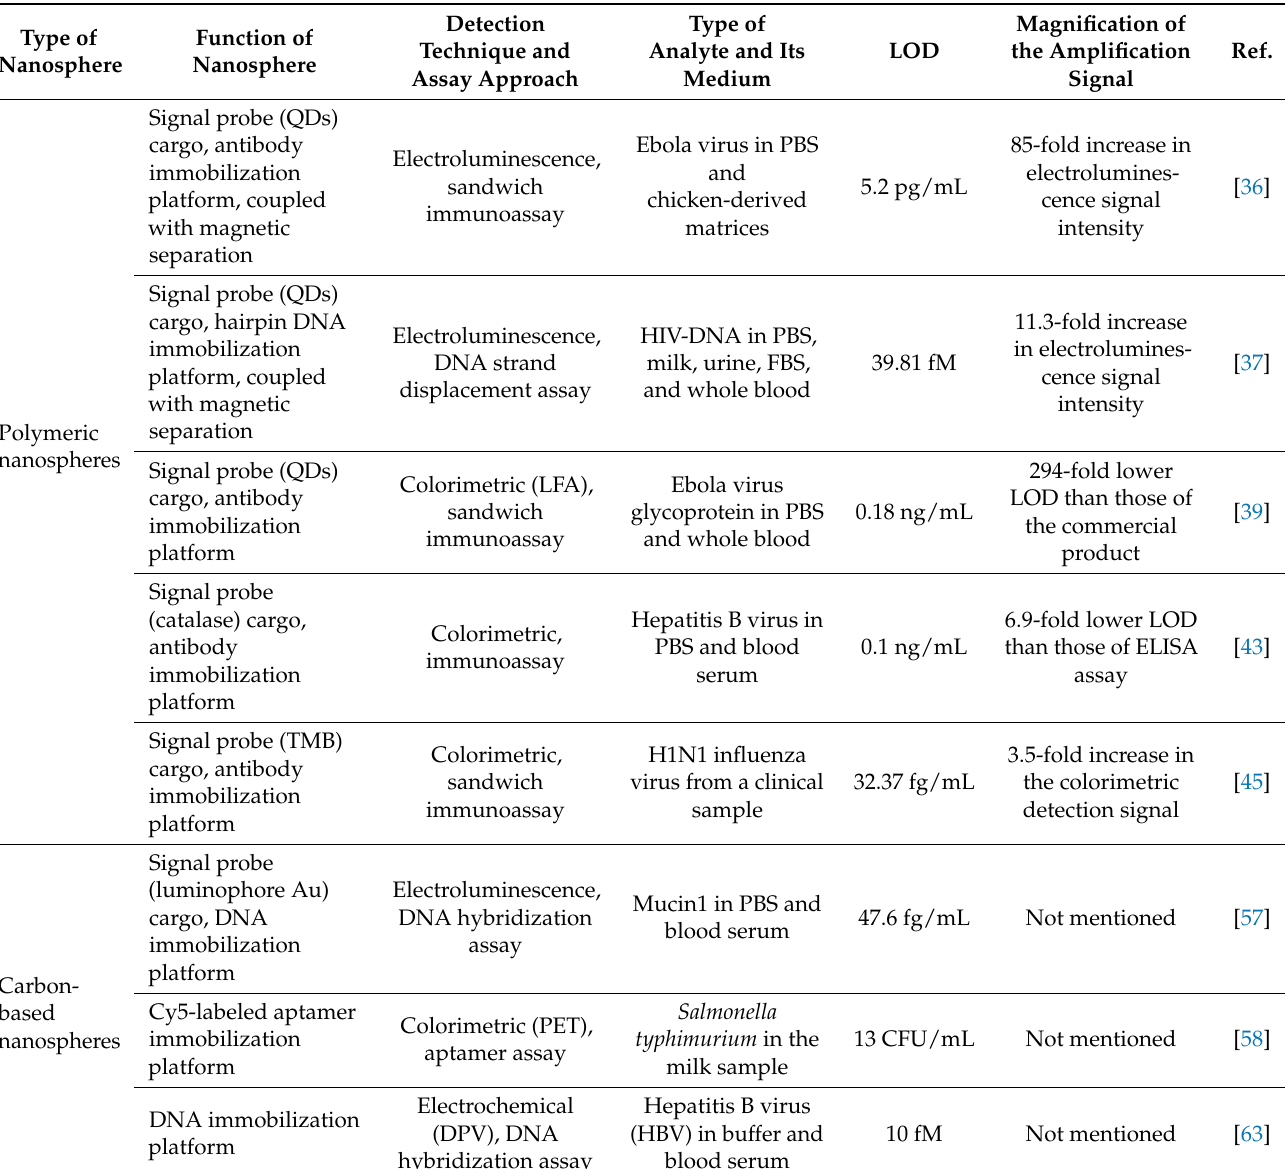
Table 1. Example of nanosphere-based signal amplification